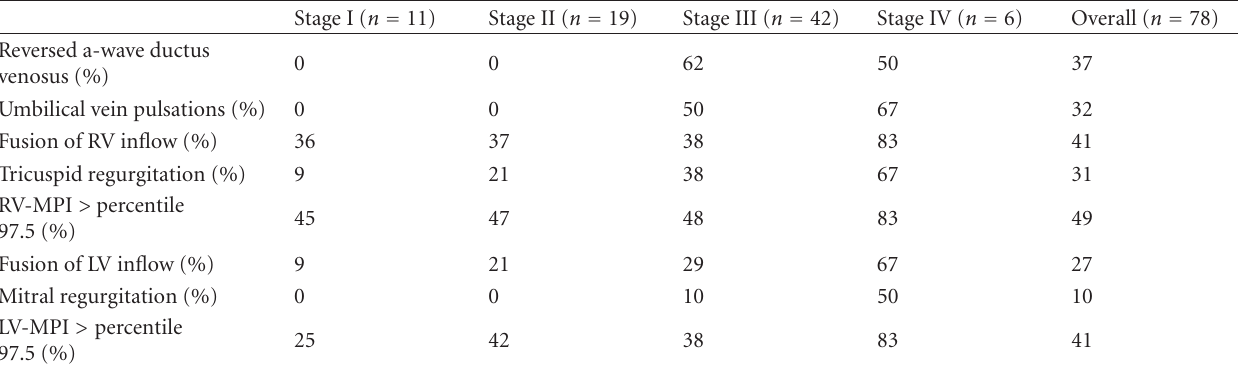
Table 1: Occurence of cardiac function alterations in 78 consecutive recipient fetuses assessed at the University Hospitals Leuven,